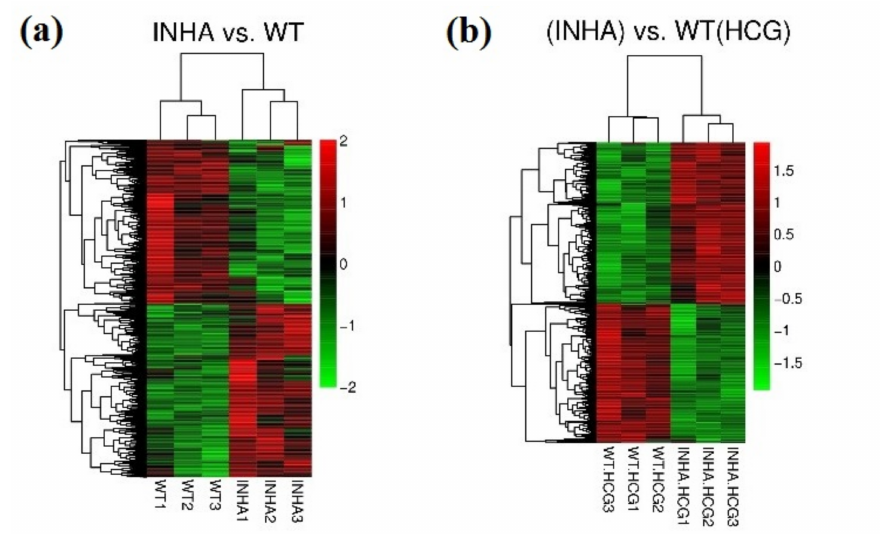
Figure 1. Hierarchical clustering heatmap of DEGs in group Inha − / − vs. WT ( a ) and Inha − / − (hCG) vs. WT(hCG) ( b ).